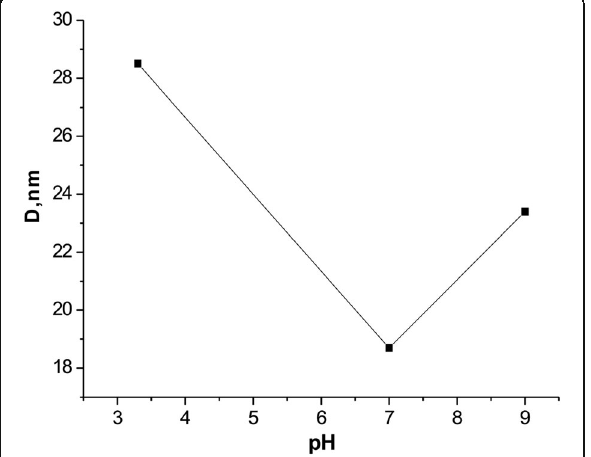
Fig. 4 CRD system of dependence on the pH of the reaction